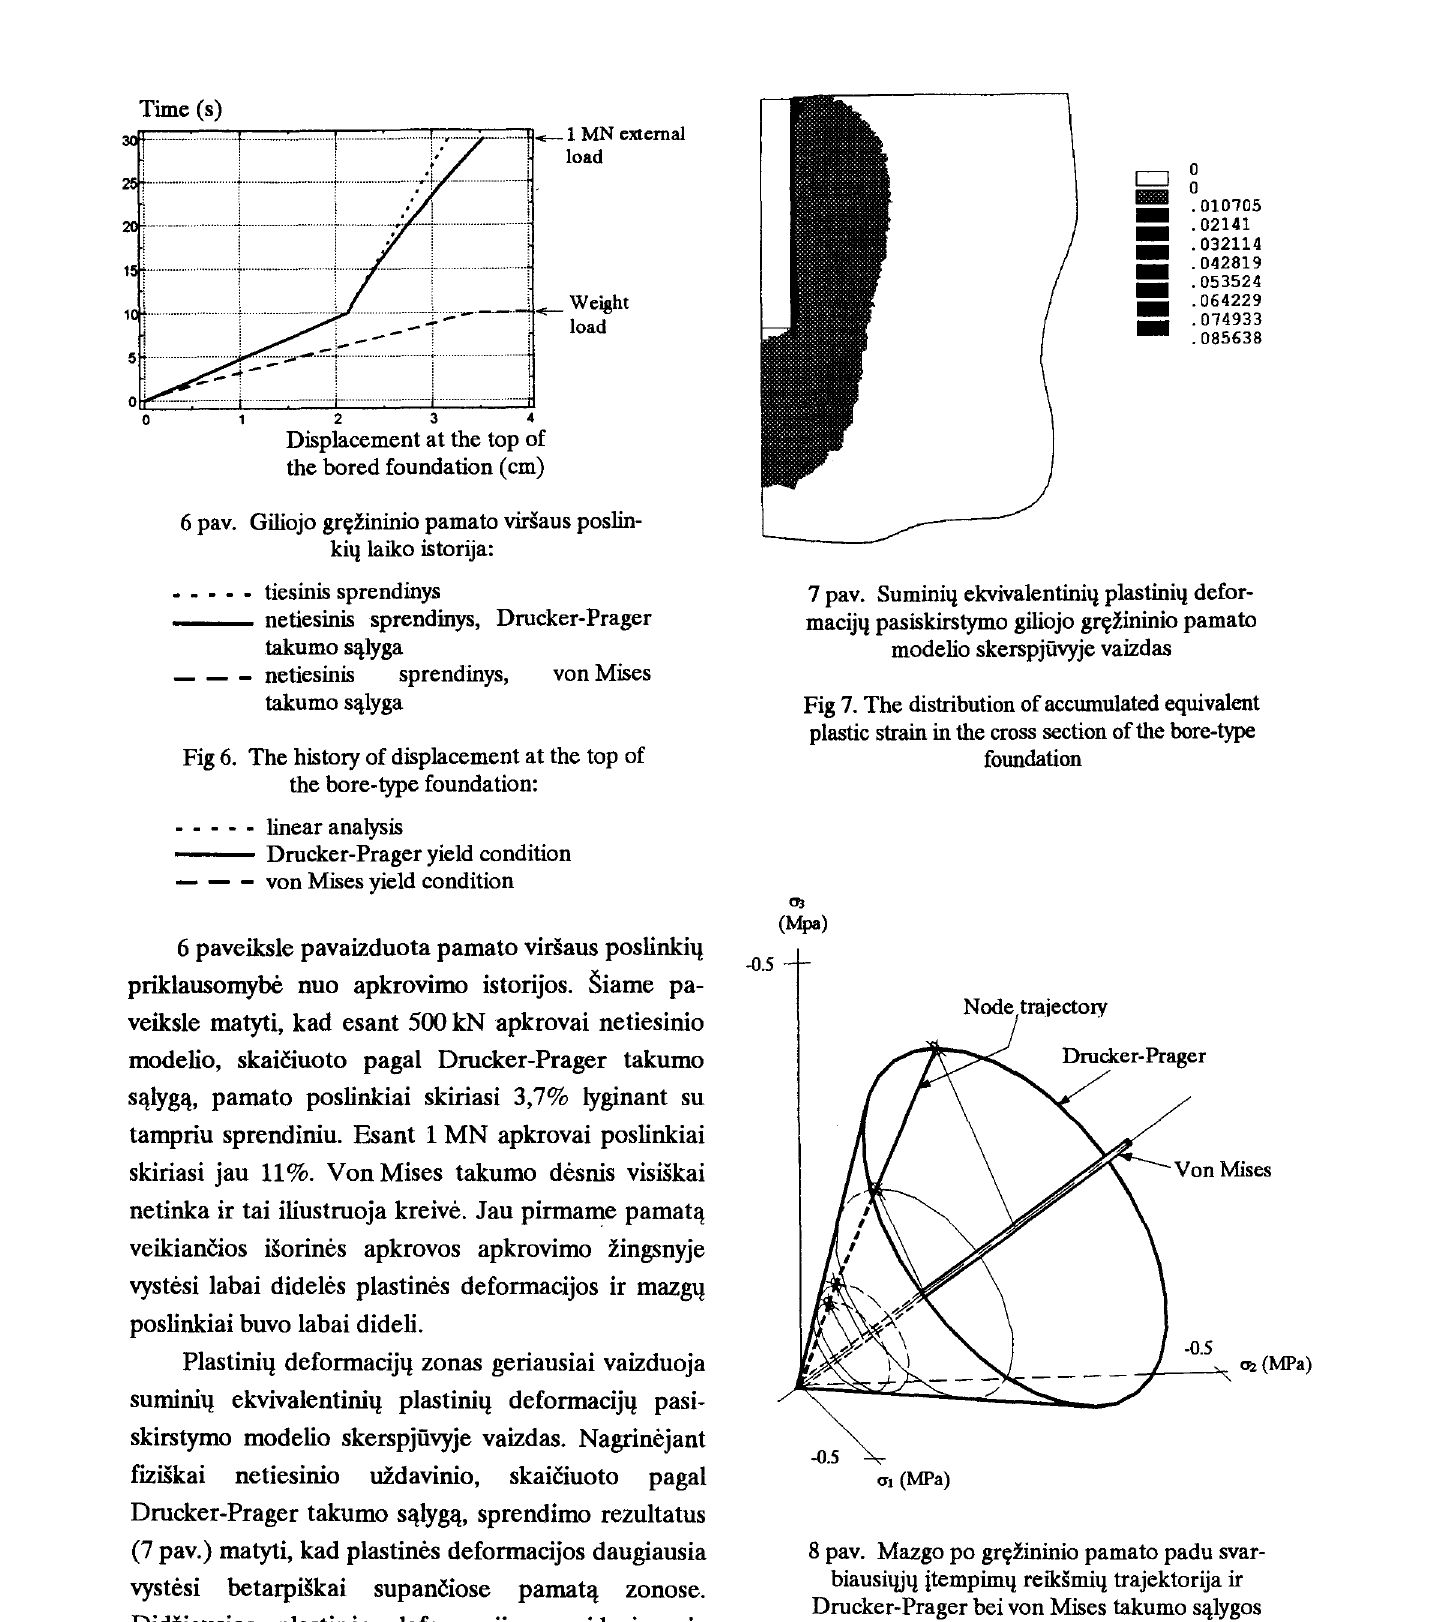
Fig 8. The history of the principal stresses of the node under the foundation, Drucker-Prager and von Mises yield surfaces in principal stress